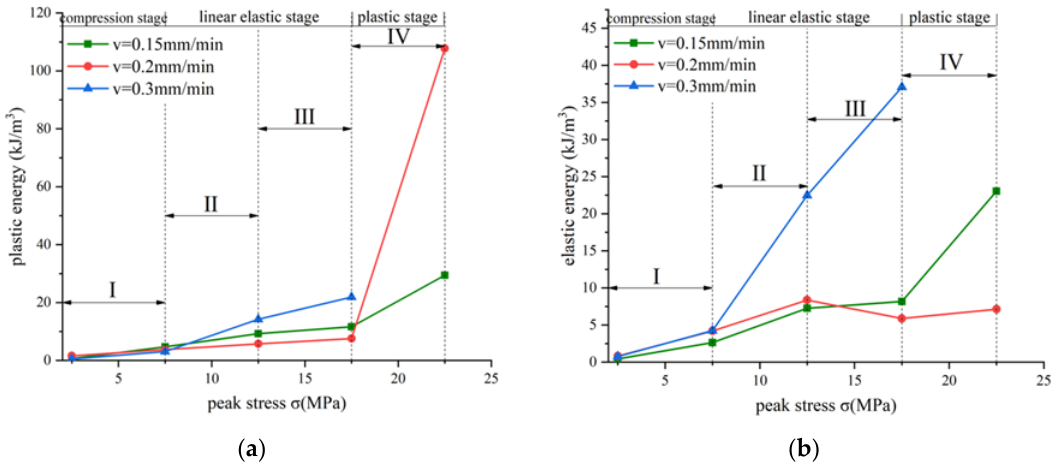
Figure 9. Change processes of plastic energy and elastic energy at different loading rates. ( a ) Plastic energy (I: stable increase, II: rapid increase, III: slow increase, IV: large increase); and ( b ) elastic energy (I: stable increase, II: rapid increase, III: slow increase or decrease, IV: sudden increase).